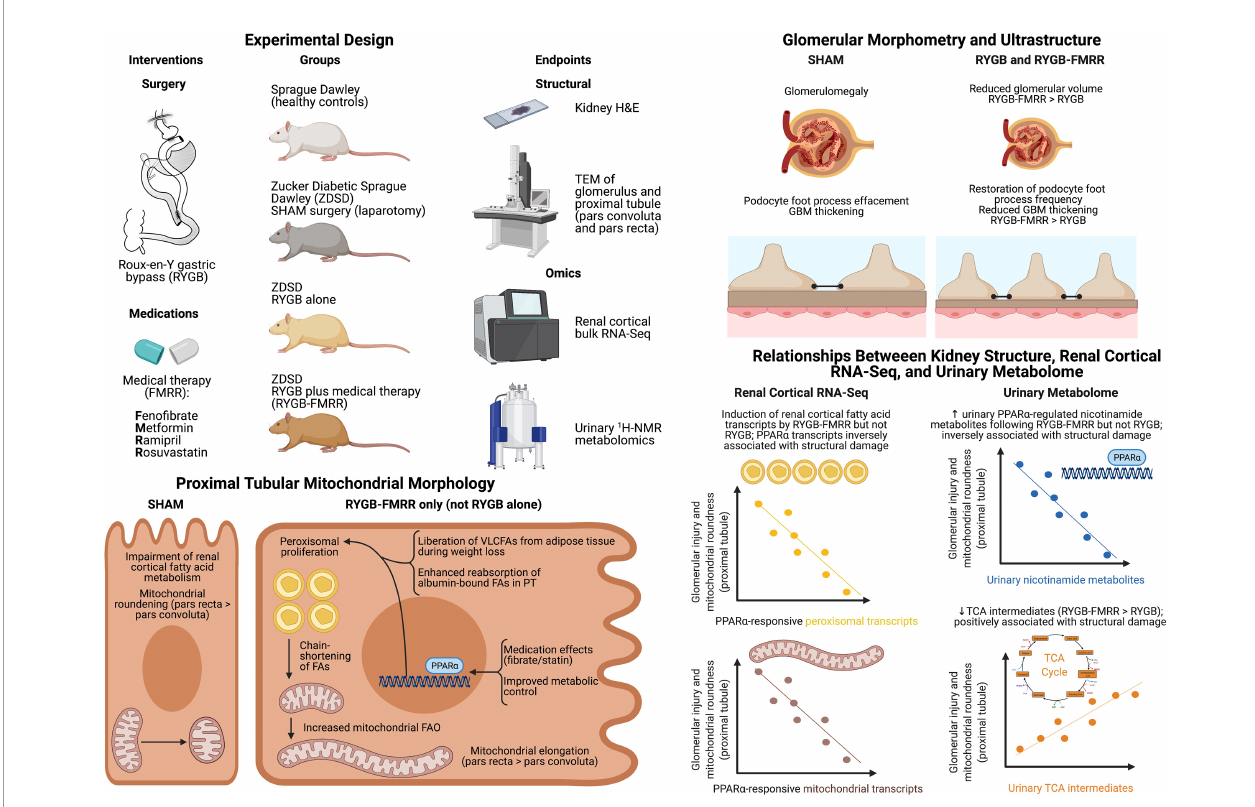
FIGURE 12 | Overview schematic. Created with BioRender.com. 1 H-NMR, proton nuclear magnetic resonance spectroscopy; FA, fatty acid; FAO, fatty acid oxidation; FMRR, feno fi brate, metformin, ramipril, and rosuvastatin; GBM, glomerular basement membrane; H&E, haematoxylin and eosin; PPAR a , peroxisome proliferator-activated receptor-alpha; PT, proximal tubule; RNA-Seq, ribonucleic acid next-generation sequencing; RYGB, Roux-en-Y gastric bypass; RYGB-FMRR, Roux-en-Y gastric bypass plus feno fi brate, metformin, ramipril, and rosuvastatin; SD, Sprague Dawley; SHAM, sham surgery (laparotomy); TCA, tricarboxylic acid; TEM, transmission electron microscopy; UAER, urinary albumin excretion rate; VLCFA, very-long-chain fatty acid; ZDSD, Zucker Diabetic Sprague